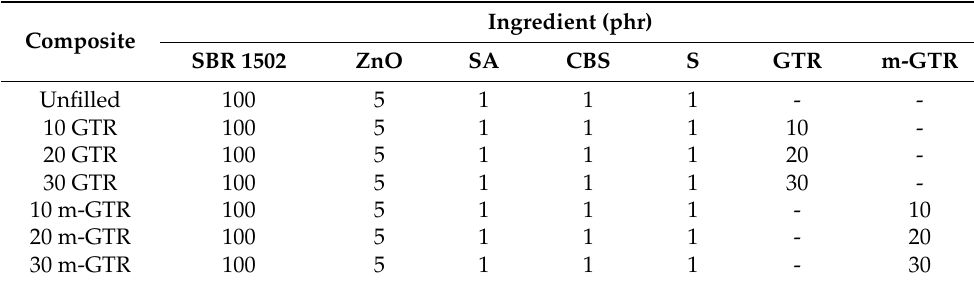
Table 2. Formulations of styrene-butadiene rubber (SBR) composites. ZnO: zinc oxide, SA: stearic acid, CBS: N-cyclohexylbenzothiazole-2-sulfenamide, S: sulfur, GTR: ground tire rubber (cryo-ground GTR), m-GTR: modified ground tire